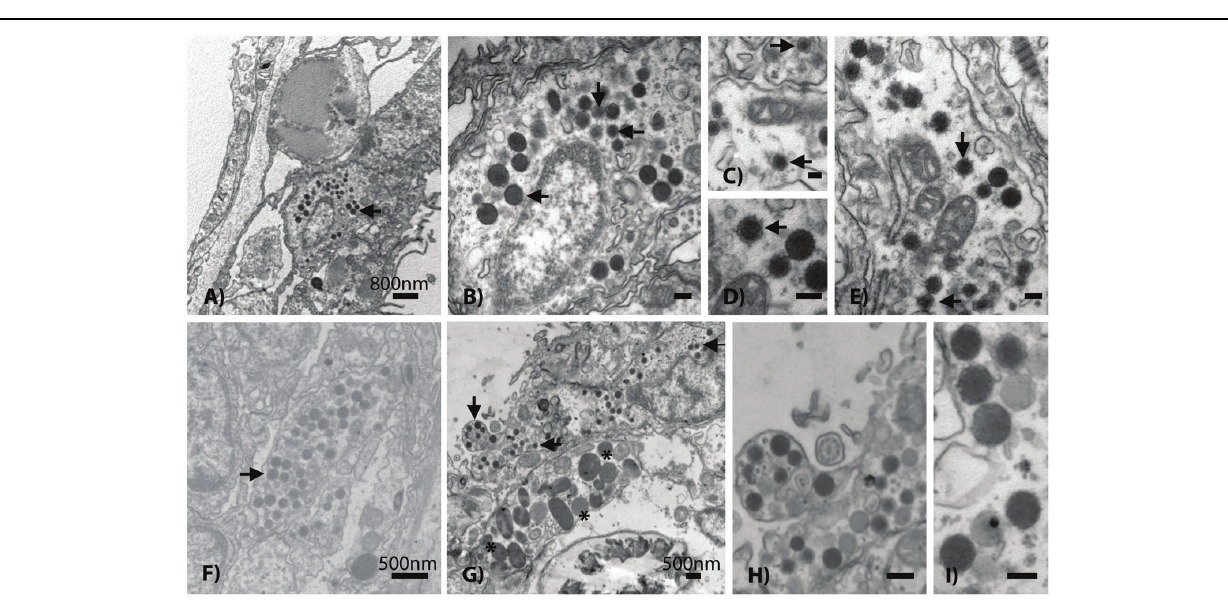
FIGURE 4 | Representative examples of the acroporid atypical herpes-like virus from Acropora aspera coral fragments. These abundant herpes-like VLPs are comprised of enveloped, icosahedral (non-tailed) capsids ranging from 120 to 150 nm in diameter and contain electron dense cores. The VLPs in (F) are within a cellular vacuole; this is characteristic of herpesviruses. (B) is an enlargement of (A) ; (D) is an enlargement of (E) ; (H) is an enlargement of (G) . (A,B) and (G–I) are images of the control saline-injected coral treatment fragments used to generate the viral metagenome. Arrows in (A–G) indicate general examples of atypical herpes-like viral particles. Asterisks indicate bacterial cells. Scale bars are 100 nm, unless otherwise